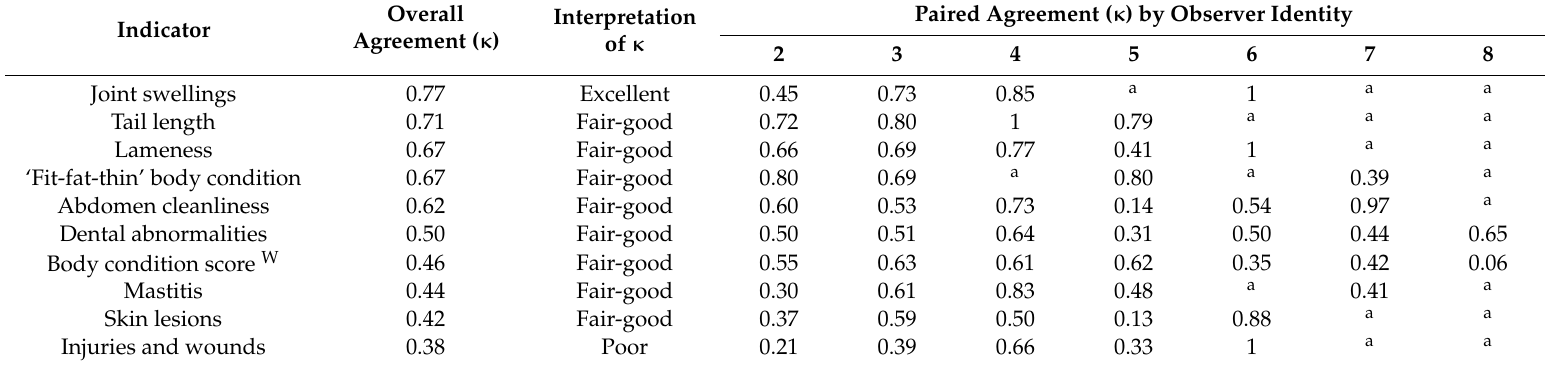
Table 4. Overall inter-observer kappa ( κ ) agreement for multiple observer assessments ( n > 2) and paired κ agreement between the test standard observer (‘TSO’: observer 1) and observers